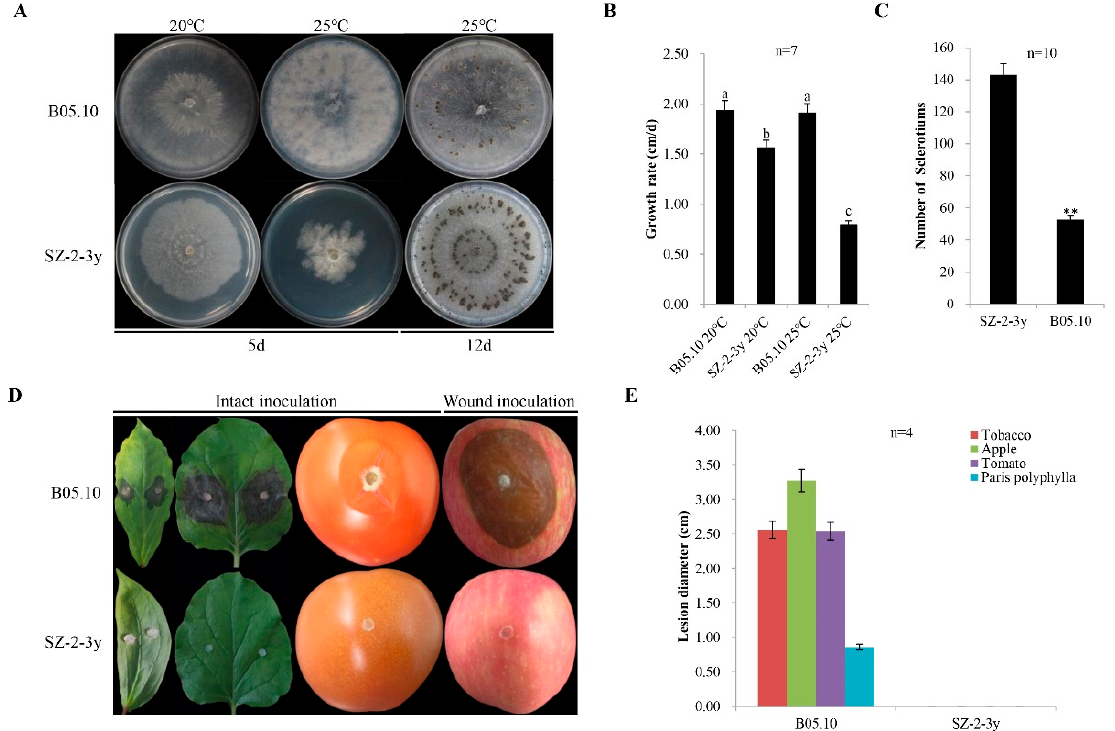
Figure 1. Culture characteristics and virulence of Botrytis cinerea isolates: ( A ) five-day-old cultures of the SZ-2-3y isolate and the B05.10 reference strain (20 °C and 25 °C) on potato dextrose agar (PDA), and production sclerotia at 20 °C for 12 days; ( B ) histogram showing average mycelial growth rates of the two isolates. Results are means ± standard deviation (SD; n = 7); ( C ) histogram showing the number of sclerotia for the two isolates (** p < 0.01); ( D ) pathogenicity of B. cinerea isolates on leaves of Paris polyphylla and tobacco, fruits of tomato following intact inoculation with mycelia, and apple fruits following wound inoculation with the mycelia using isolates of SZ-2-3y and B05.10, respectively (20 °C, 4 dpi); ( E ) histogram showing average lesion diameters of leaves of P. polyphylla and tobacco, and fruits of tomato and apple, caused by the two isolates. B05.10 served as a reference strain in the above experiments.